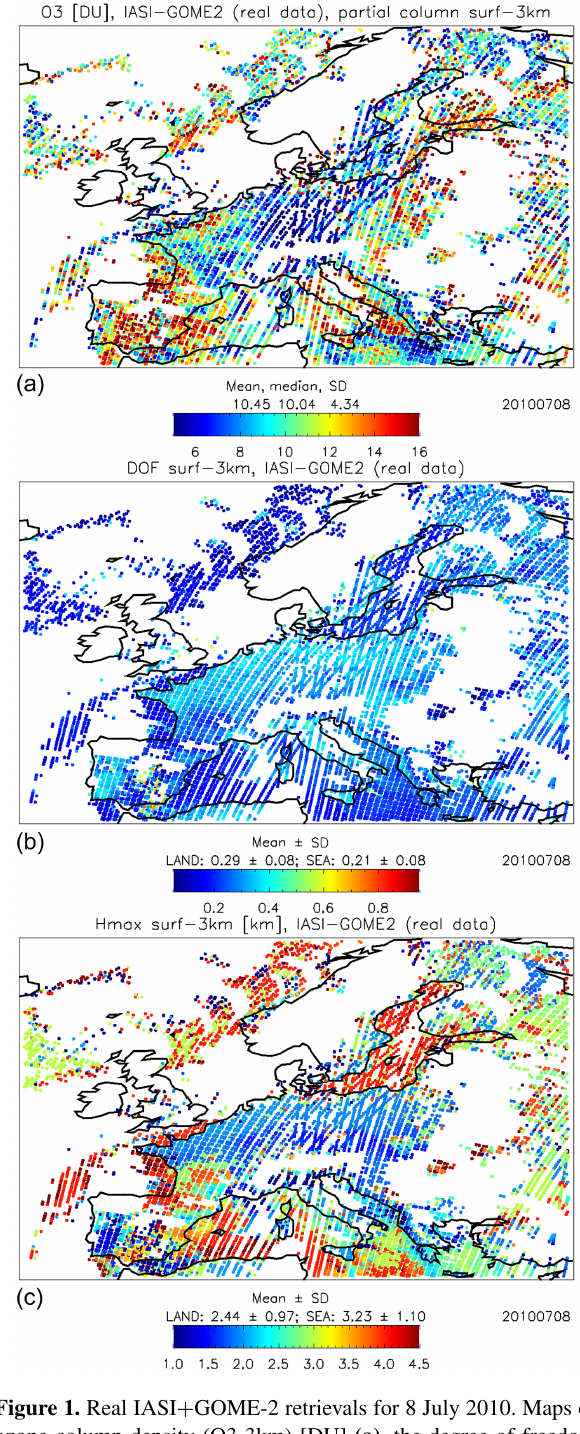
Figure 1. Real IASI + GOME-2 retrievals for 8 July 2010. Maps of ozone column density (O3-3km) [DU] (a) , the degree of freedom (DOF-3km) (b) , and the altitude of maximum sensitivity (Hmax- 3km) [km] calculated between the surface and 3km altitude (c) . White areas indicate a lack of measurements due to the presence of relatively high cloud fraction (>30%), unavailability of satellite data or invalid